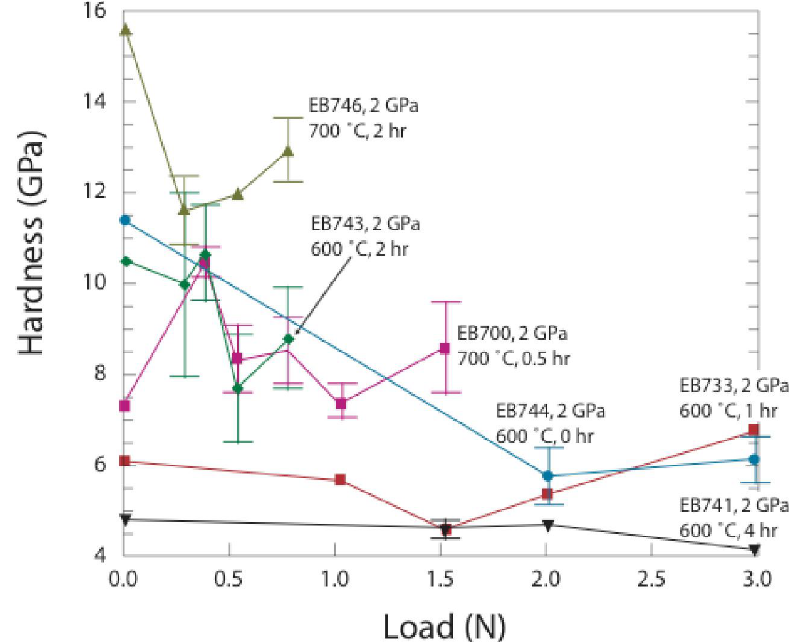
N nanocomposite ceramics 3 4